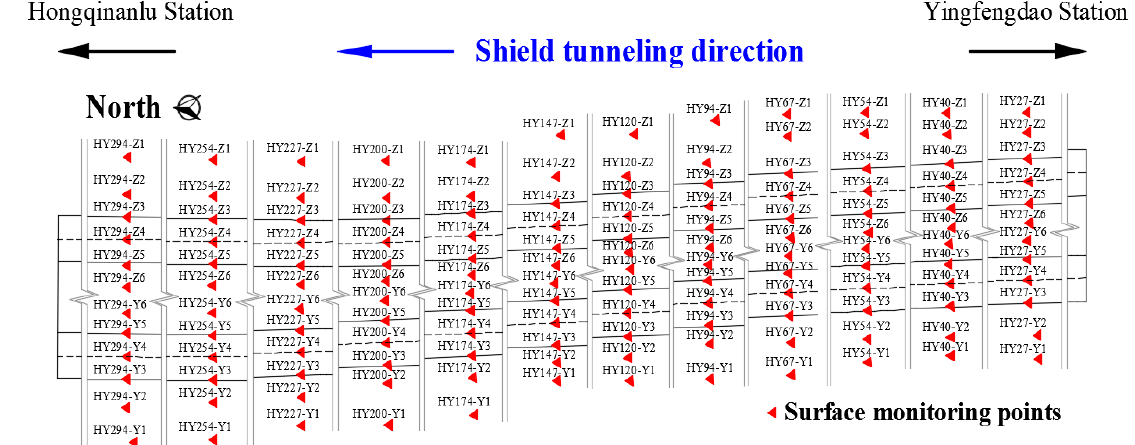
Figure 3. Layout of monitoring sections.